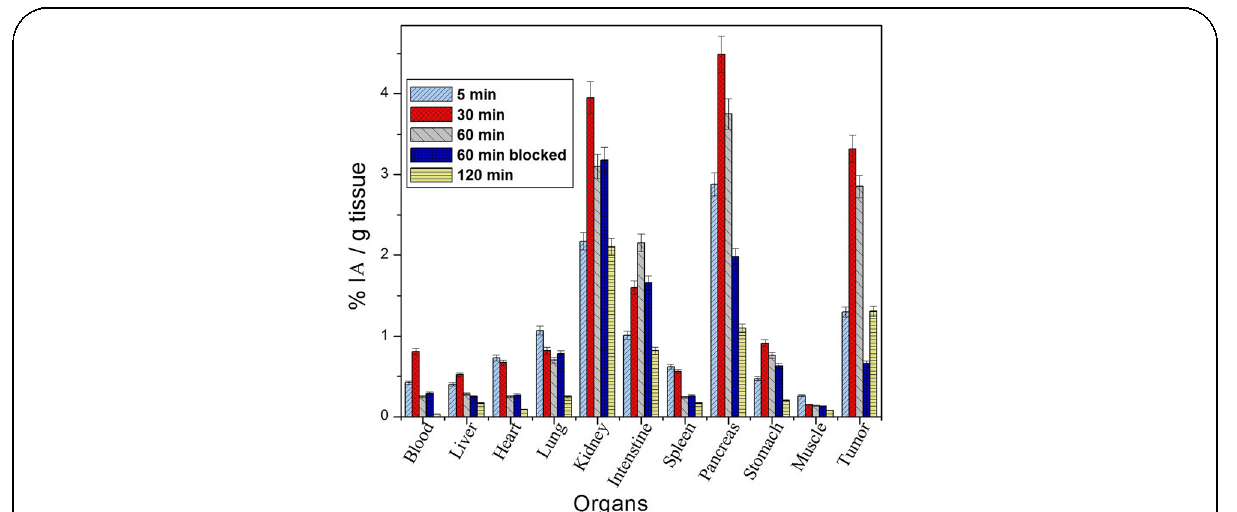
Fig. 9 Biodistribution study of 99m Tc-BN4 in MDA-MB-231 cell-induced tumor-bearing mice at 5, 30, 60, and 120 min post injection with or without a co-administration of blocking peptide (BNS). All the data represent %IA/g values and each values are the mean±SD of three animals per time point ( N =3)